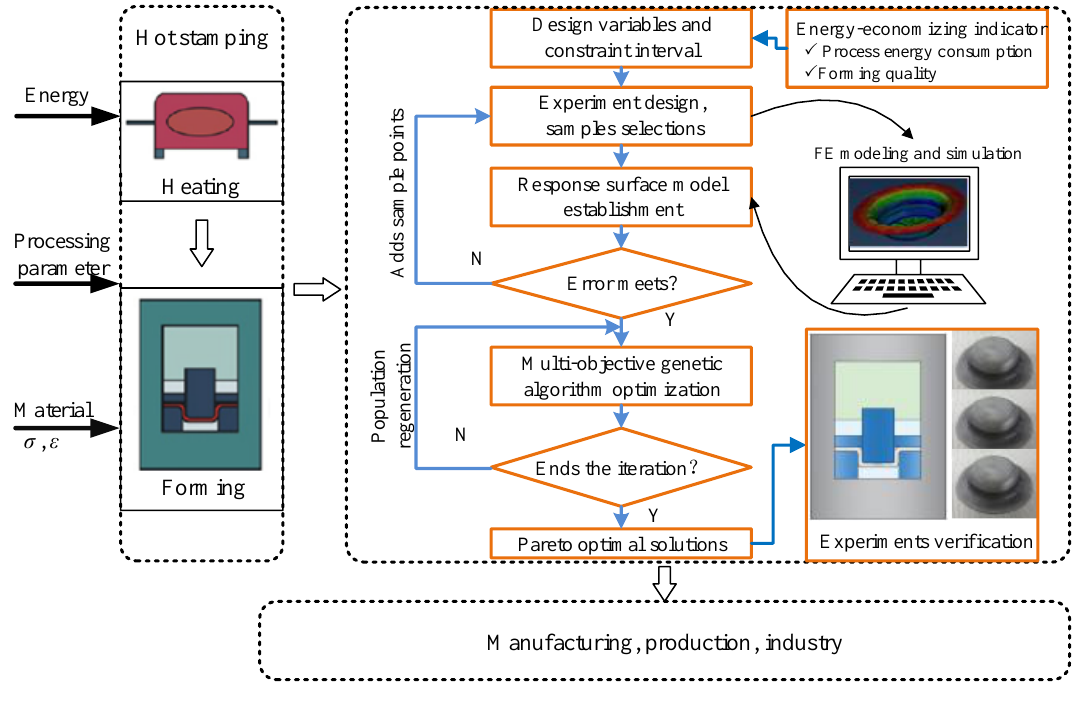
Figure 1. Methodological framework.